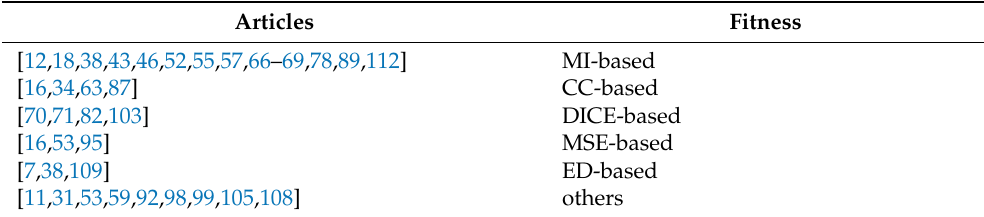
Table 4. Fitness functions used in the reviewed